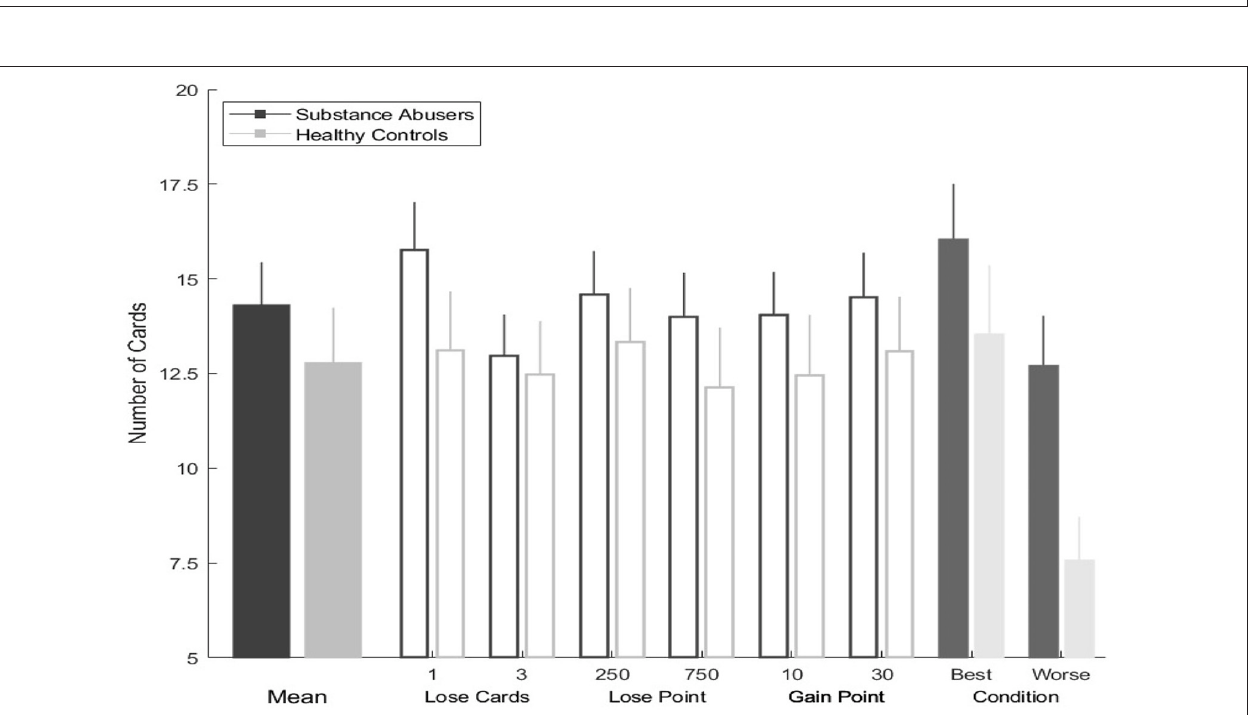
FIGURE 5 | Columbia card task cold version performance in each condition by